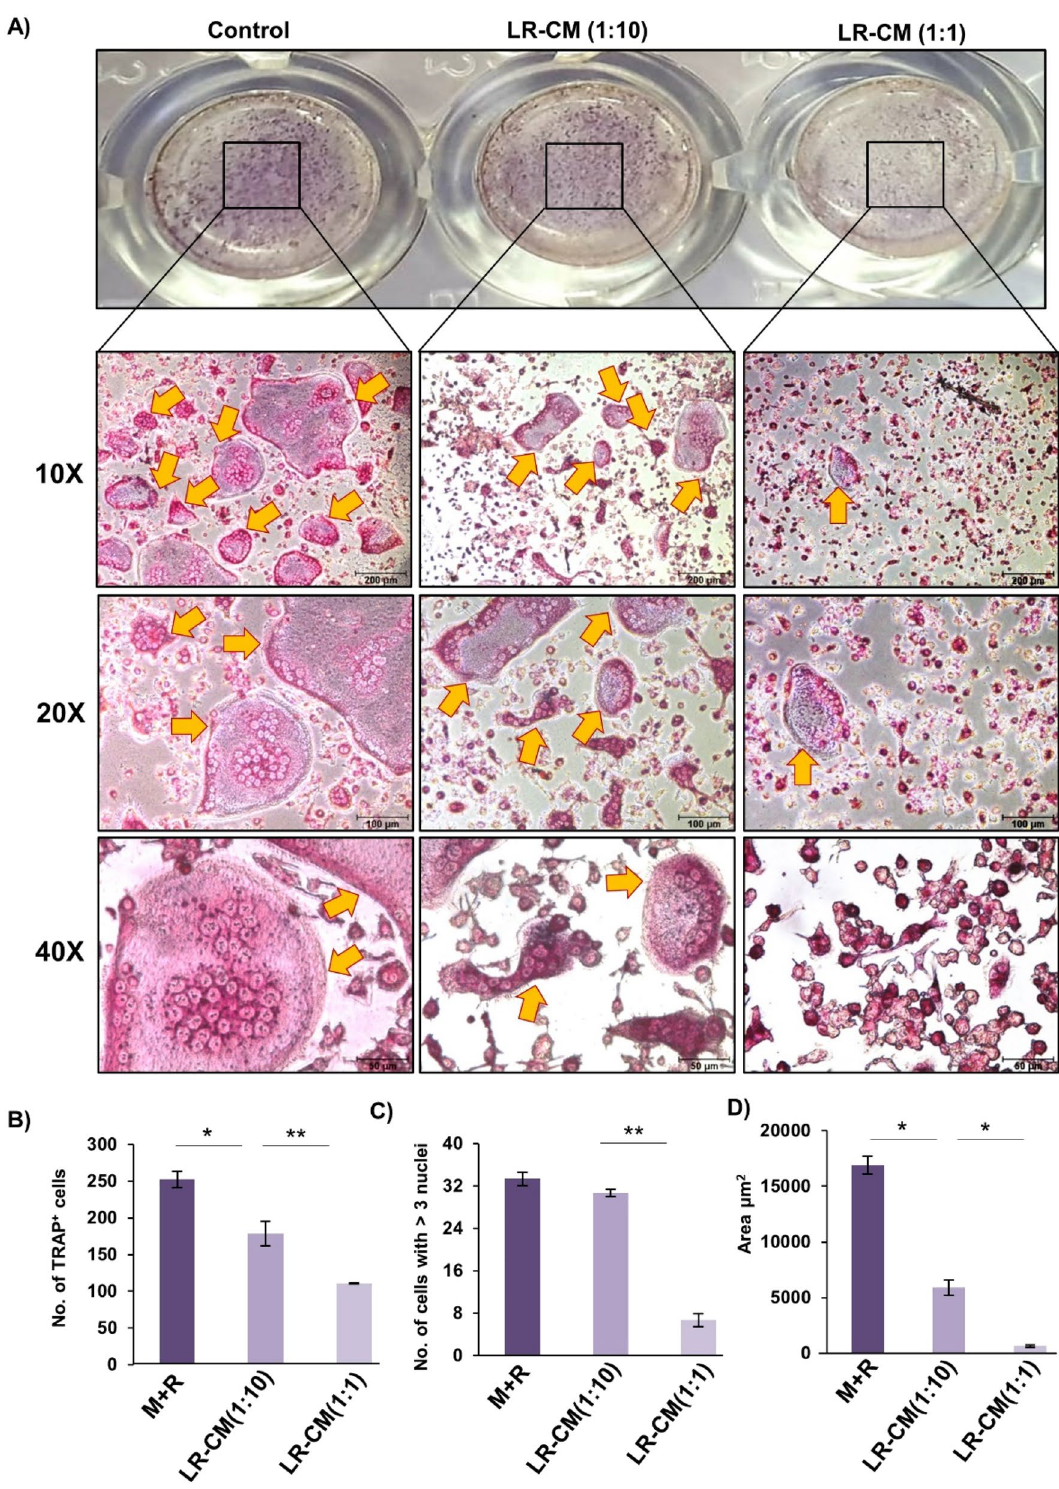
Figure 1. LR-CM inhibits osteoclastogenesis in a dose dependent manner: Osteoclasts differentiation was induced in Bone Marrow Macrophages (BMMs) with M-CSF (30 ng/ml) and RANKL (100 ng/ml) with or without Lactobacillus rhamnosus —conditioned media (LR-CM) at different ratios of 1:10 and 1:1 for 6 days. Giant multinucleated cells were stained with TRAP and cells with ≥ 3 nuclei were considered as mature osteoclasts. ( A ) Photomicrographs at different magnifications (10×, 20× and 40×) were taken. ( B ) Number of TRAP positive cells. ( C ) Number of TRAP positive cells with more than 3 nuclei. ( D ) Area of osteoclasts. The above images are indicative of one independent experiment and similar results were obtained in three different independent experiments. Statistical significance was considered as p ≤ 0.05 (* p ≤ 0.05, ** p ≤ 0.01, *** p ≤ 0.001) with respect to indicated